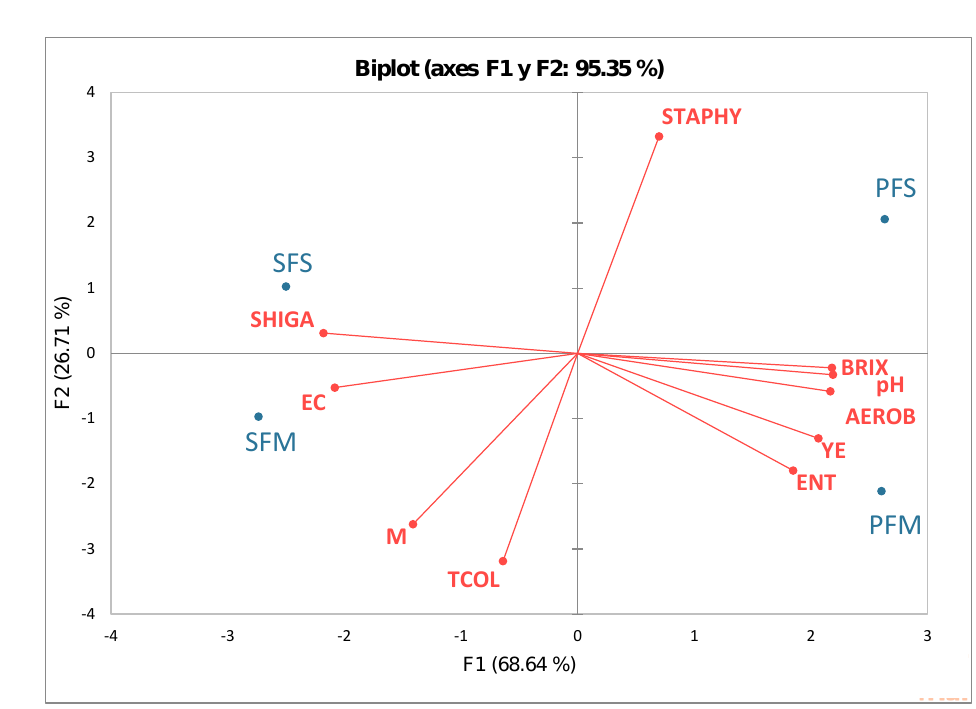
Data represent mean ± standard deviation of 3 experimental repetitions (-): not detected. Legend: SFS-strawberries from a local farm grower; SFM: strawberries from low-cost market; PFS: gooseberries from a local farm grower; PFM: gooseberries from low-cost market.